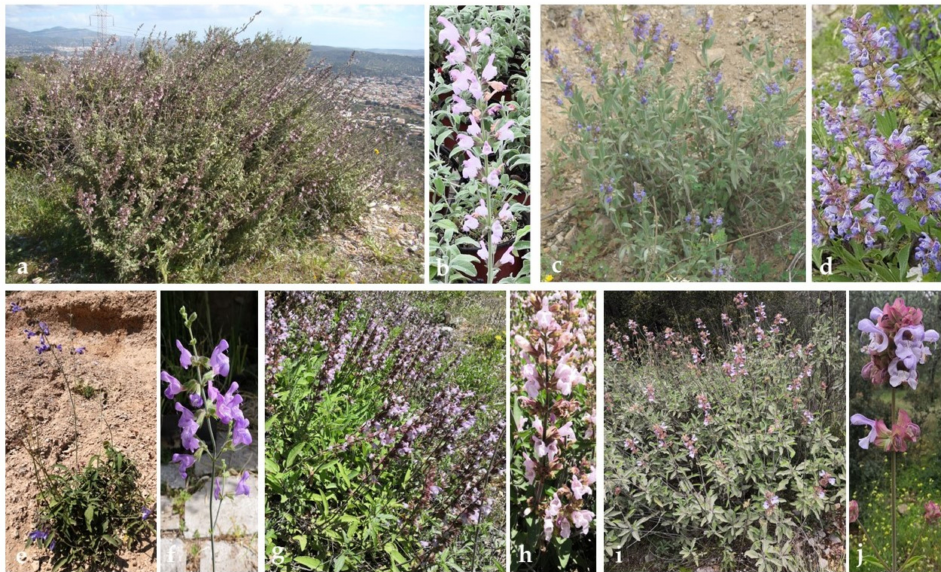
Figure 1. Native to Greece Salvia spp.; S. fruticosa plant ( a ) and inflorescence ( b ), S. officinalis plant ( c ) and inflorescence ( d ), S. ringens plant ( e ) and inflorescence ( f ), S. tomentosa plant ( g ) and inflores- cence ( h ), S. pomifera ssp. pomifera plant ( i ) and inflorescence ( j